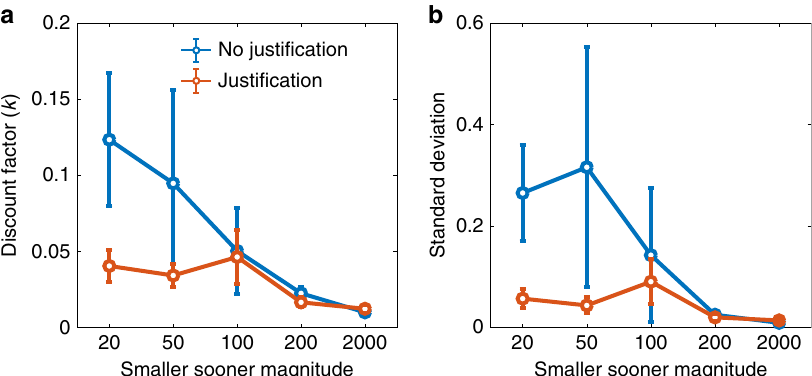
Fig. 2 Justi fi cation effect results. a Mean discount factor as a function of magnitude and justi fi cation condition. b Standard deviation of the discount factor as a function of magnitude and justi fi cation condition. Data from ref. 18 , n = 1382 participants. Data are presented as mean values and error bars show 95% con fi dence